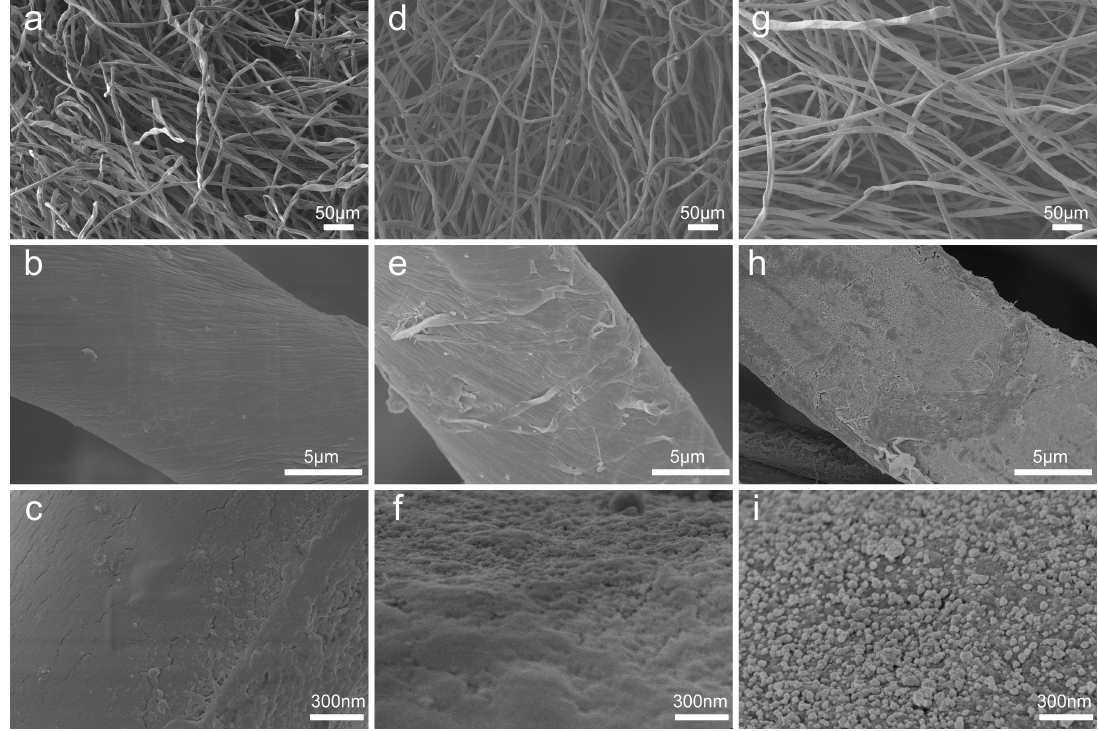
Figure 2. SEM images of the ( a – c ) original cotton swabs, ( d – f ) CS@PDA swabs and ( g – i ) Figure